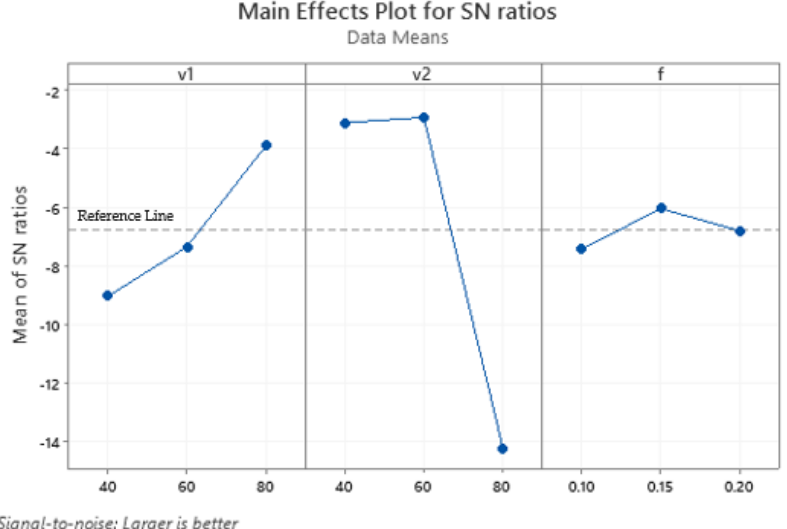
Figure 7. Main effect plot for signal-to-noise ratio (S/N) for closeness coefficients. Probability Plots